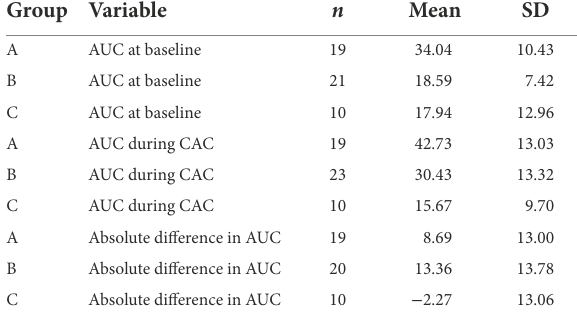
The last three lines show the difference between the two times.